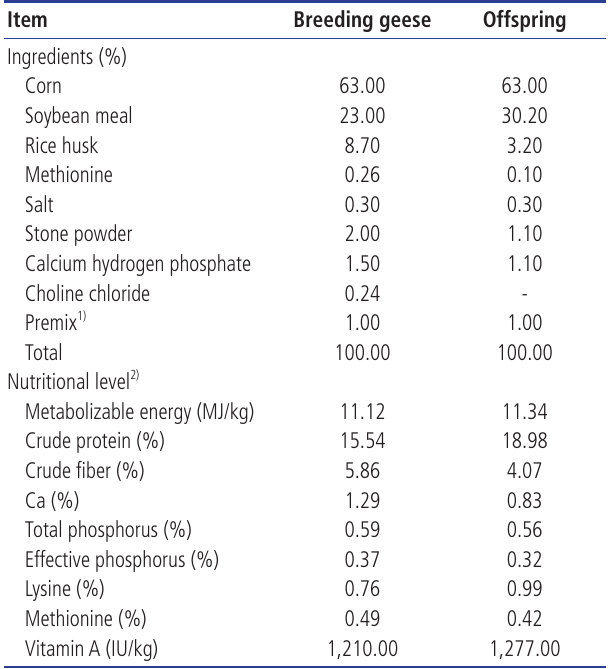
Table 1. Composition and nutrient levels of basal diets for geese and offspring (dry basis) Item Breeding